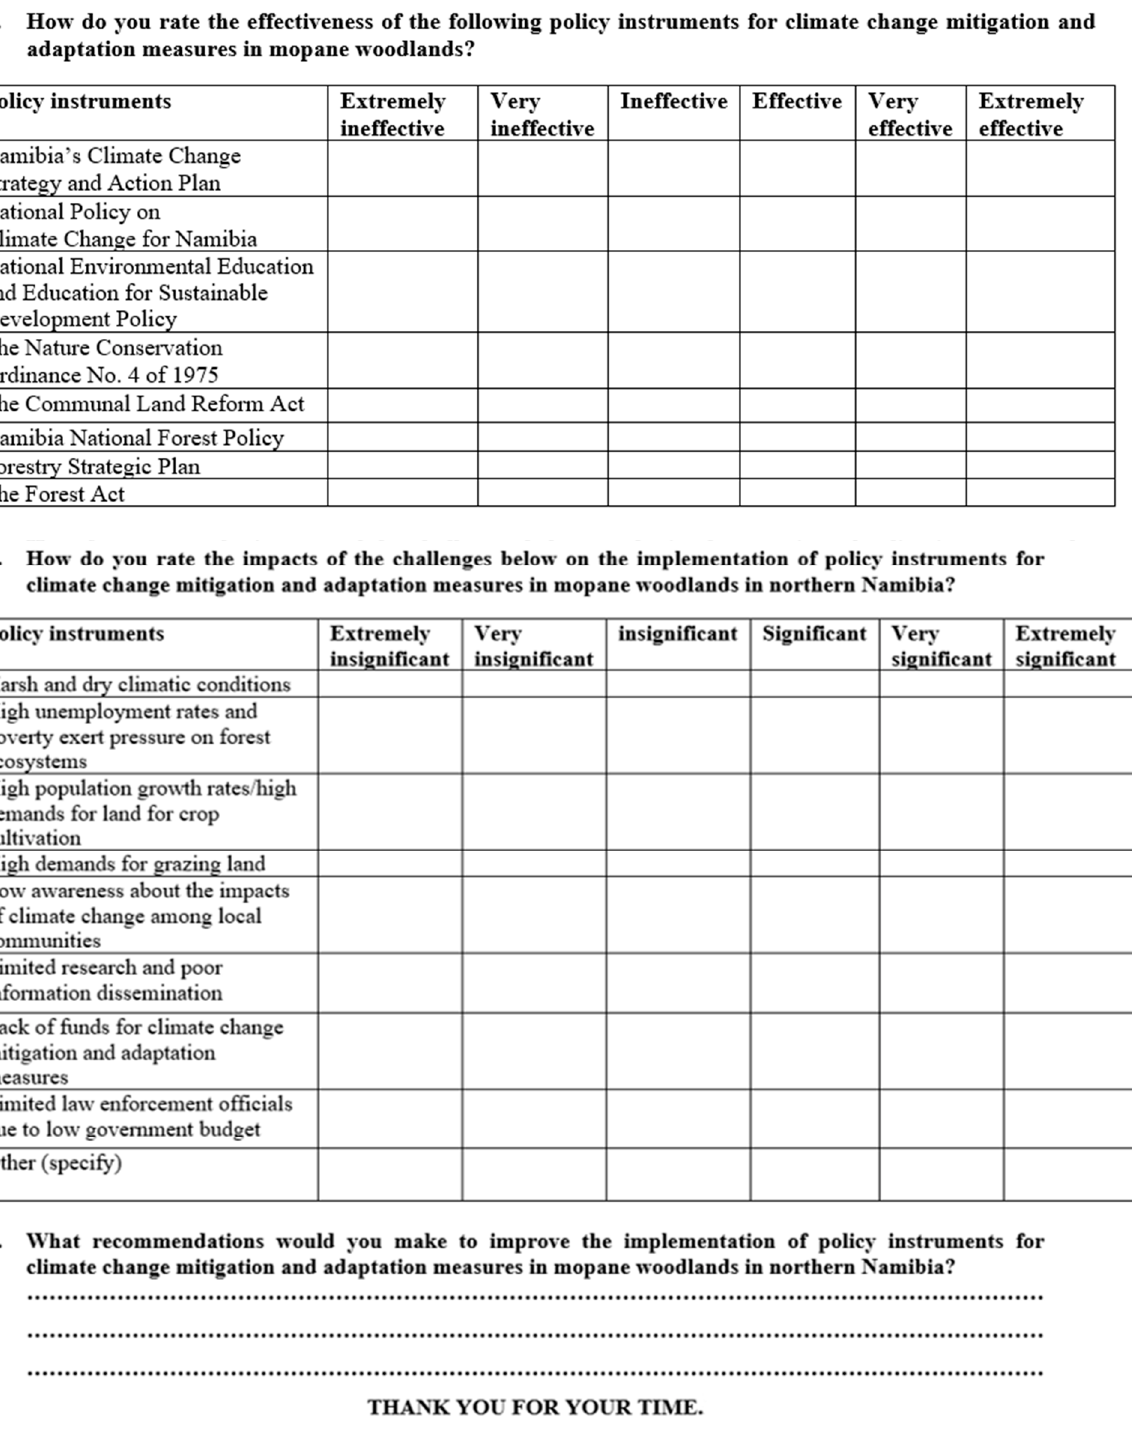
Table A1. Educational